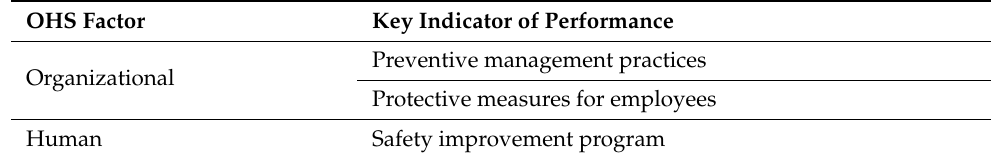
Table 16. Additional key indicators of OHS performance [23]. Key Indicator of